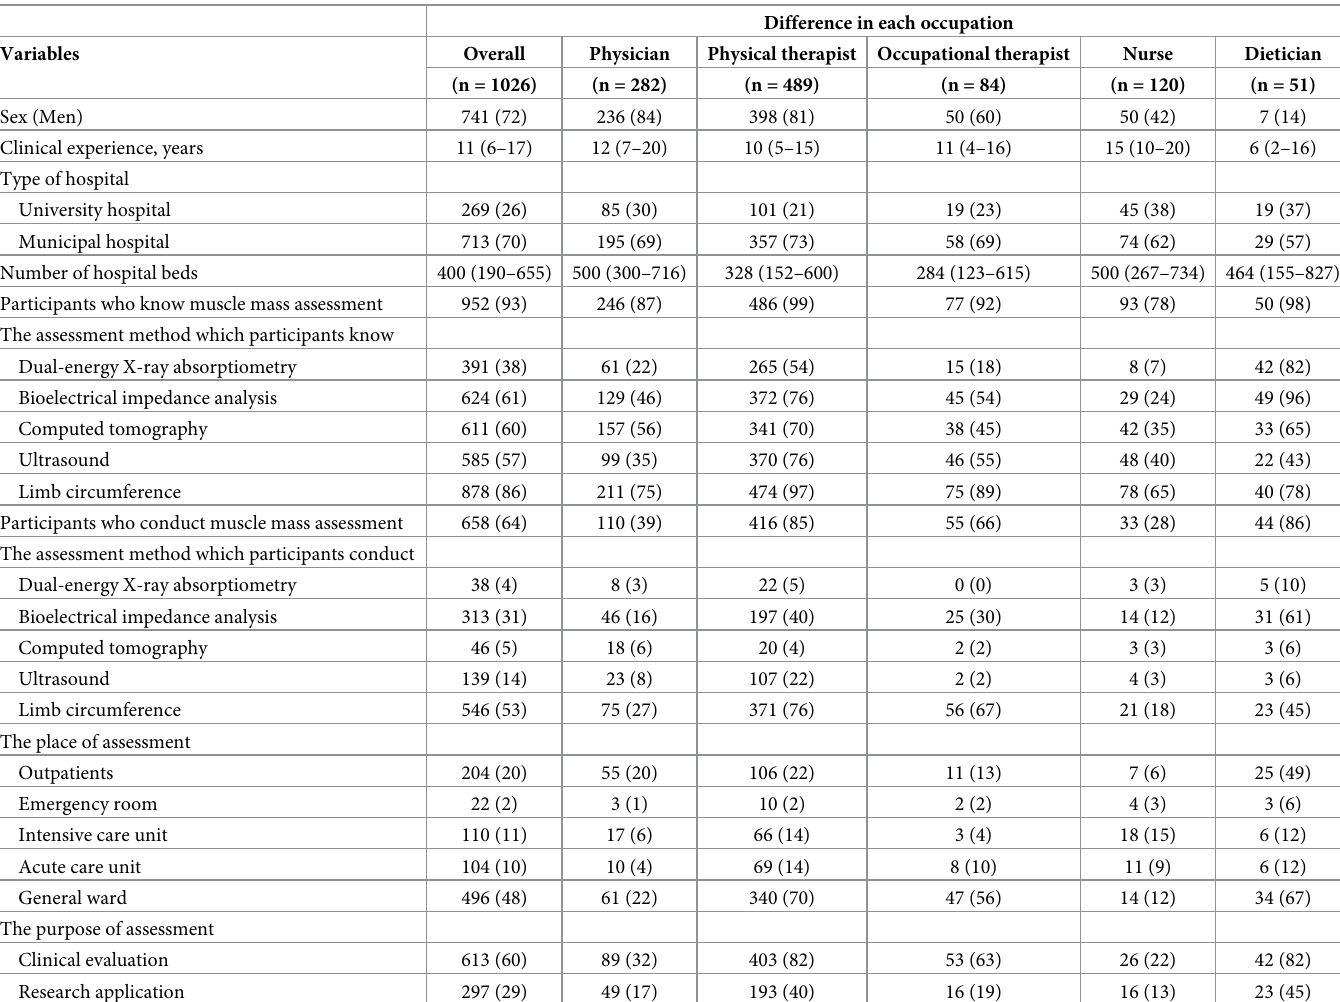
Table 1. Background and general muscle mass